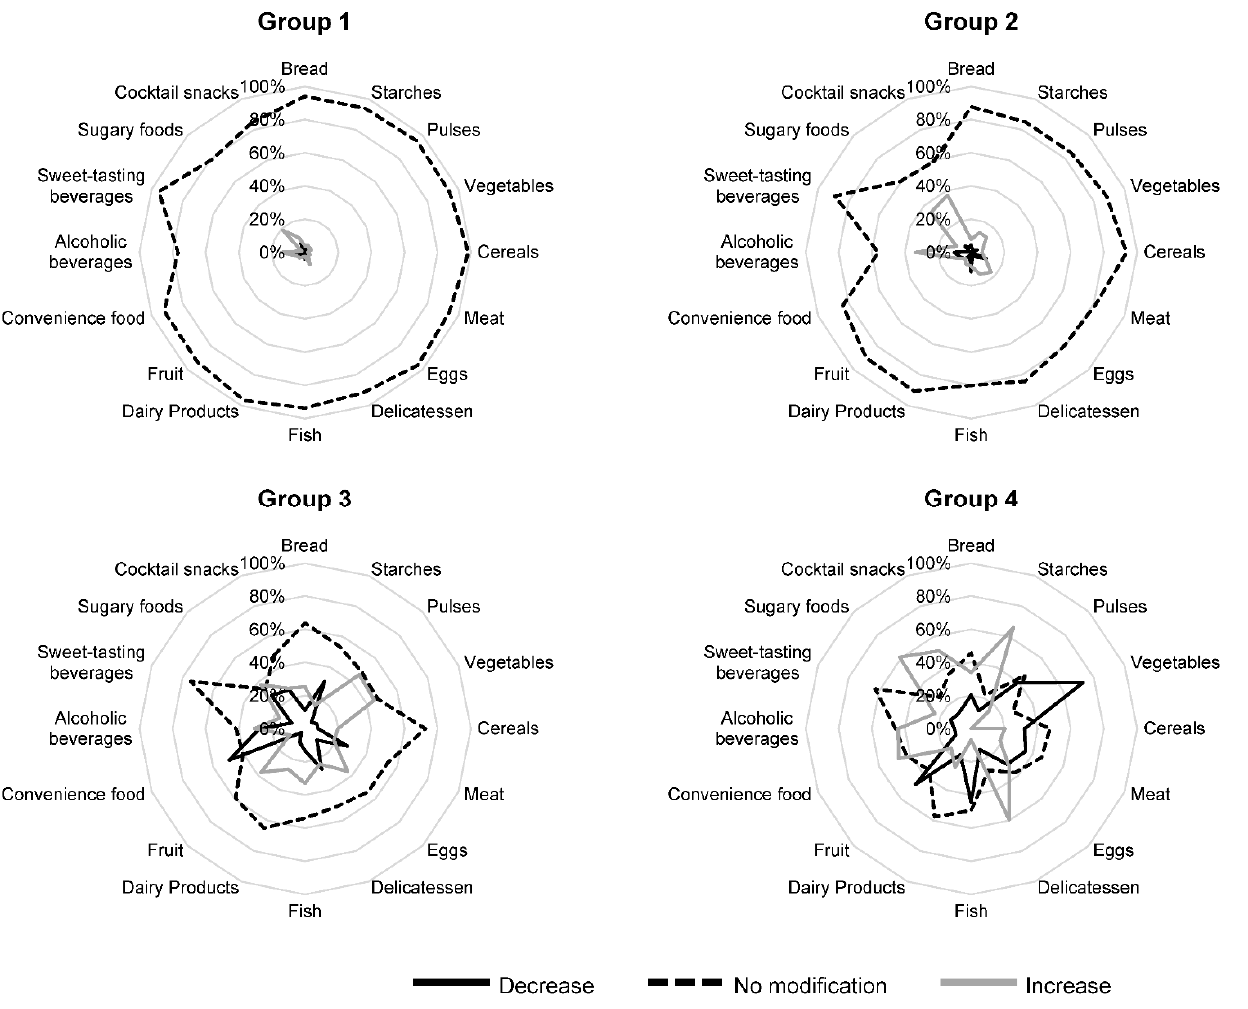
Figure 3. Description of changes in consumption of major food groups before and during the first lockdown, according to the four groups obtained after multiple-correspondence analysis. Black lines represent participants who reported a decrease during the first lockdown compared to before; gray lines represent participants who reported an increase during the first lockdown compared to before, dashed black lines represent participants who reported no modification during the first lockdown compared to before. For food consumption (number of times per week the food is eaten), a change (increase or decrease) was defined when the number was not the same before and during the first lockdown.